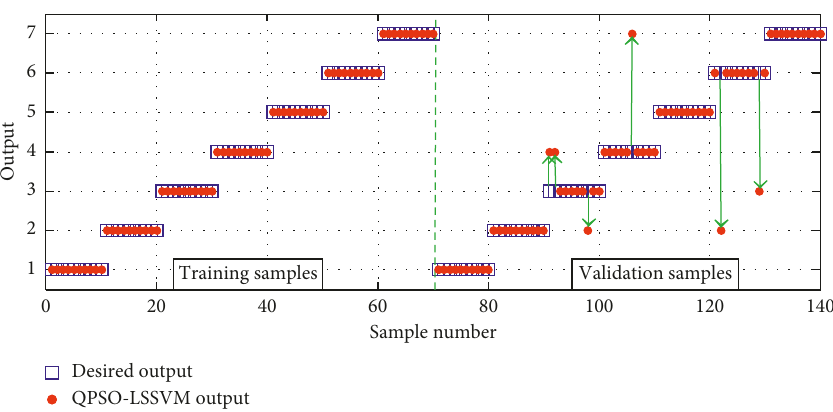
Figure 15: Classification results of the PSO-LSSVM model based on MFDFA